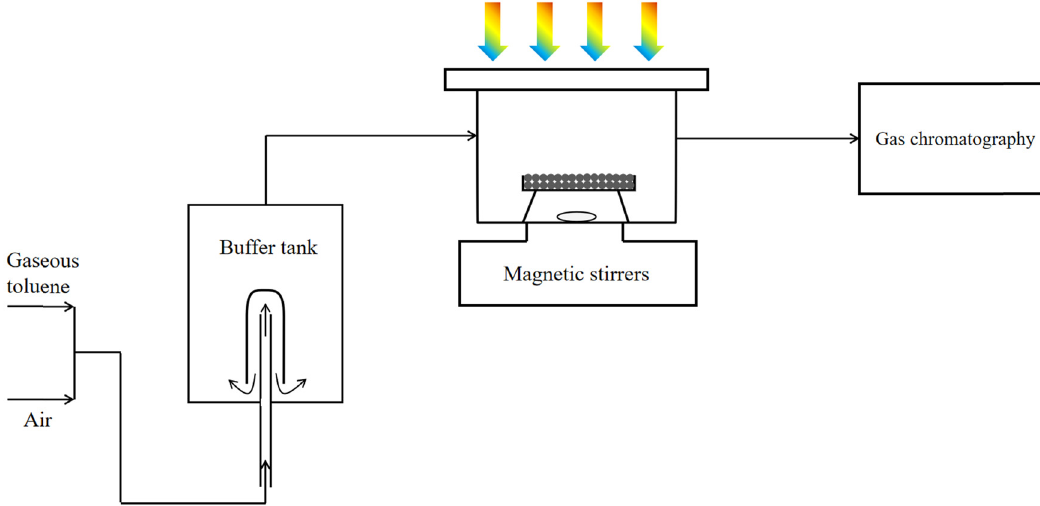
Figure 1: The process schematic of the experimental system for toluene degradation.